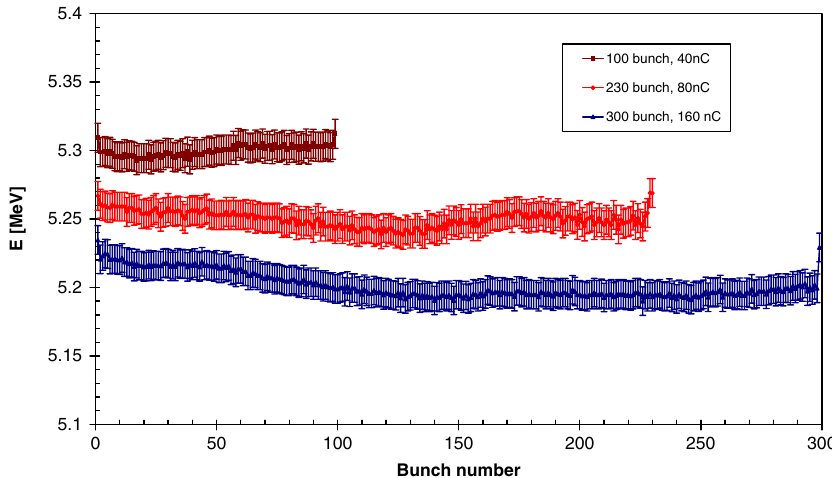
FIG. 12. The top (brown), middle (red), and bottom (blue) curve plot 100-bunch mode at 40 nC, 230-bunch mode at 80 nC, and 300-bunch mode at 160 nC,